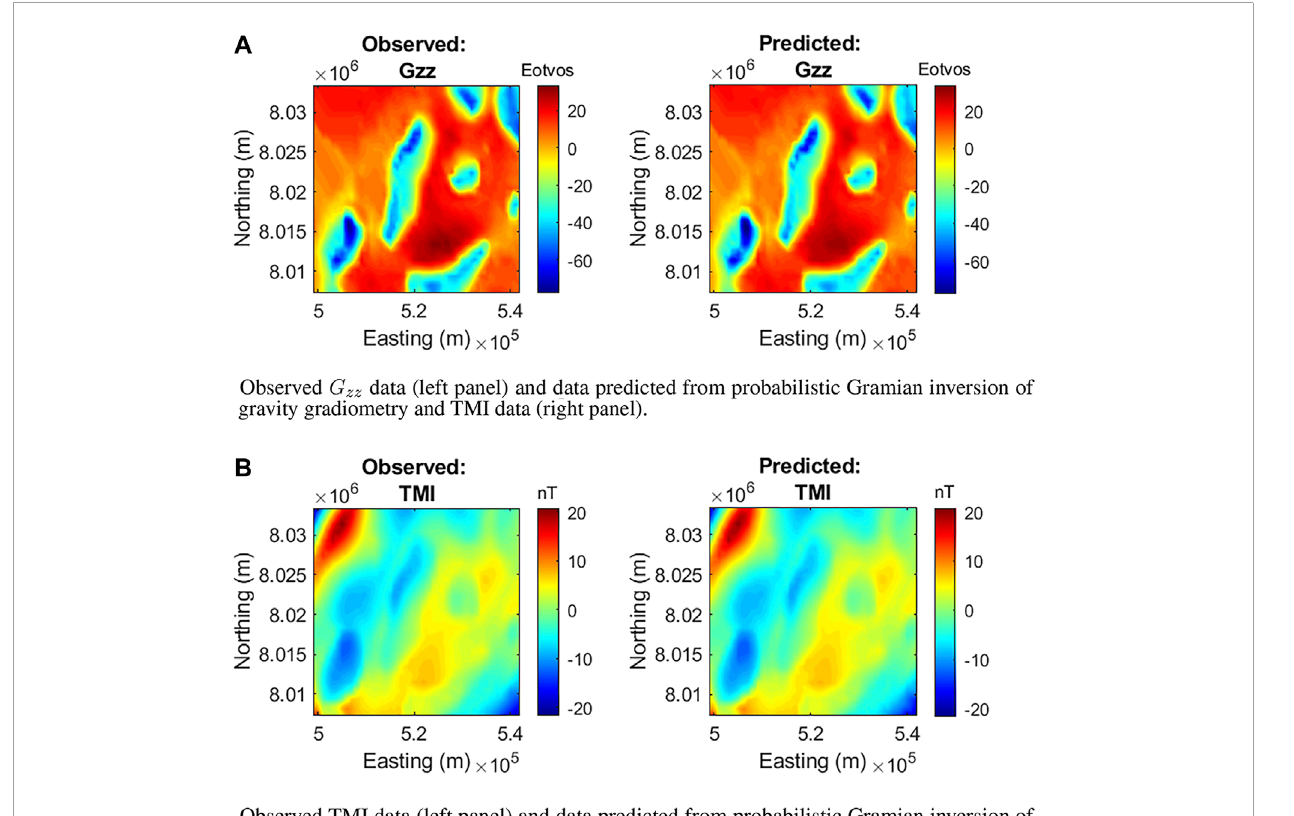
FIGURE 5 Observed and predicted data from probabilistic Gramian inversion. (A) Observed G zz data (left panel) and data predicted from probabilistic Gramian inversion of gravity gradiometry and TMI data (right panel). (B) Observed TMI data (left panel) and data predicted from probabilistic Gramian inversion of gravity gradiometry and TMI data (right